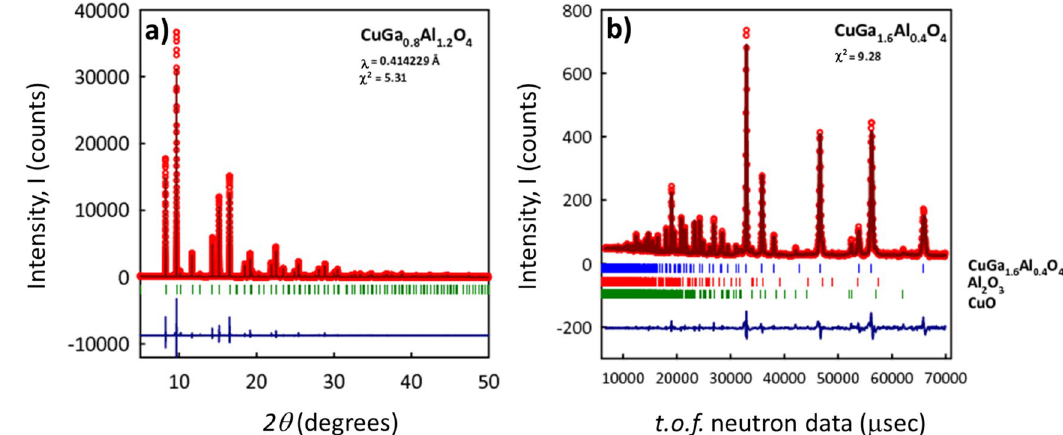
Figure 1. Examples of (a) synchrotron and (b) neutron diffraction data along with Rietveld